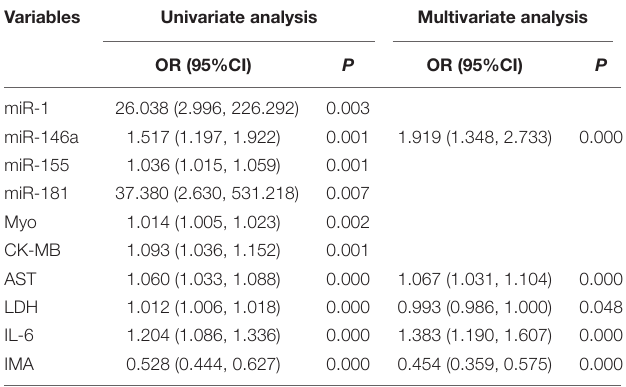
TABLE 3 | The univariate and multivariate logistic regression analysis of risk factors for cardiovascular diseases in 120 young soldiers during the 5-km run test. Variables Univariate